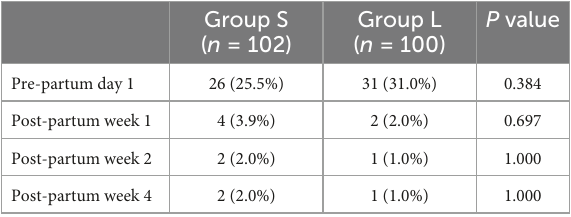
TABLE 2 The prevalence of post-partum depression (PPD) between two